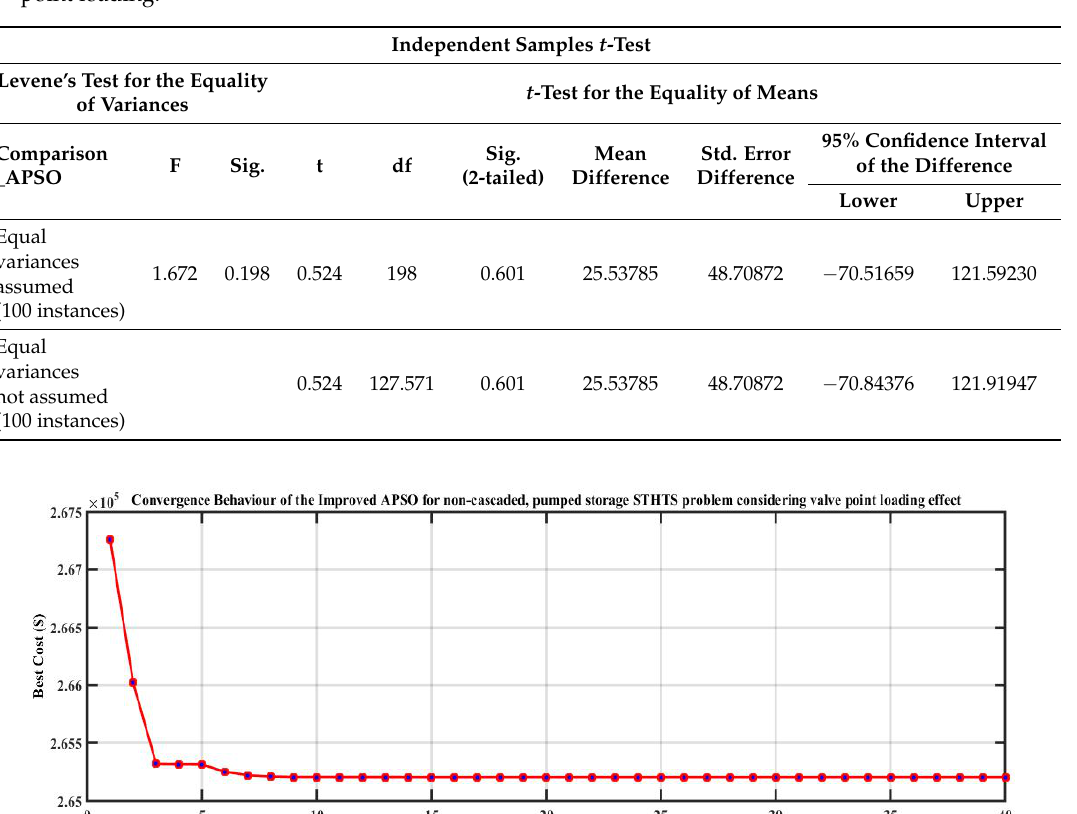
Table 10. SPSS results of the independent sample t -test showing the comparison between simple APSO and improved APSO on the non-cascaded pumped-storage STHTS problem considering valve point loading.